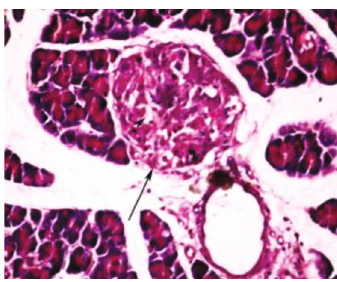
Figure 3: Photomicrograph of pancreatic tissue of insulin-treated animal showing pancreatic islet mildly restores its size and cellularity (arrow) with vacuolation in between cells (arrowhead) and congested blood capillary (double arrowhead) (H&E) ( × 400).